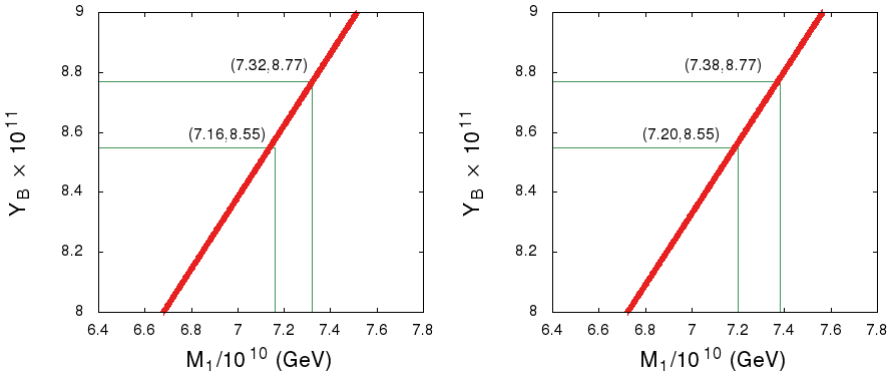
Figure 5 . Y B vs. M 1 plots corresponding to (cid:31) 2 = 0 : 397 for the normal mass ordering of the light min neutrinos. The plot in the left is for M 2 =M 1 = 10 2 and the plot in the right is for M 2 =M 1 = 10 4